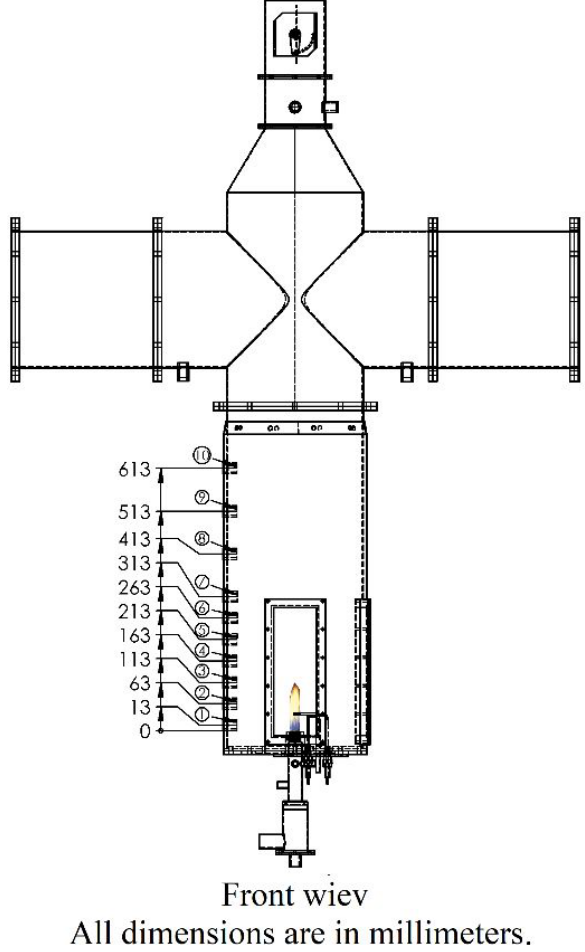
Figure 3: Thermocouple and emission measurements